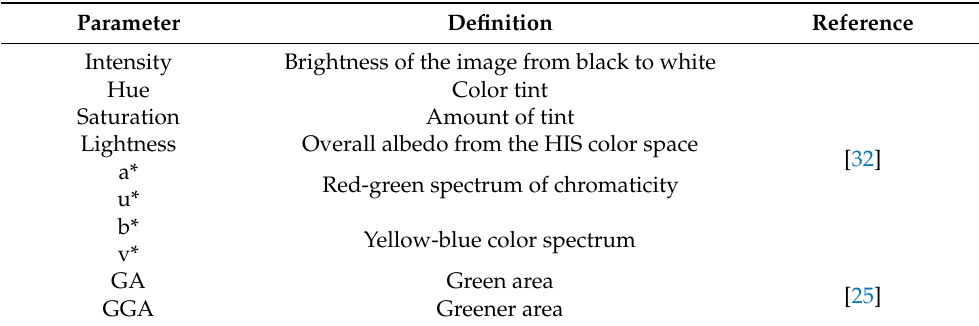
Table 2. Red-green-blue (RGB) vegetation indices, based on different color properties, used in the